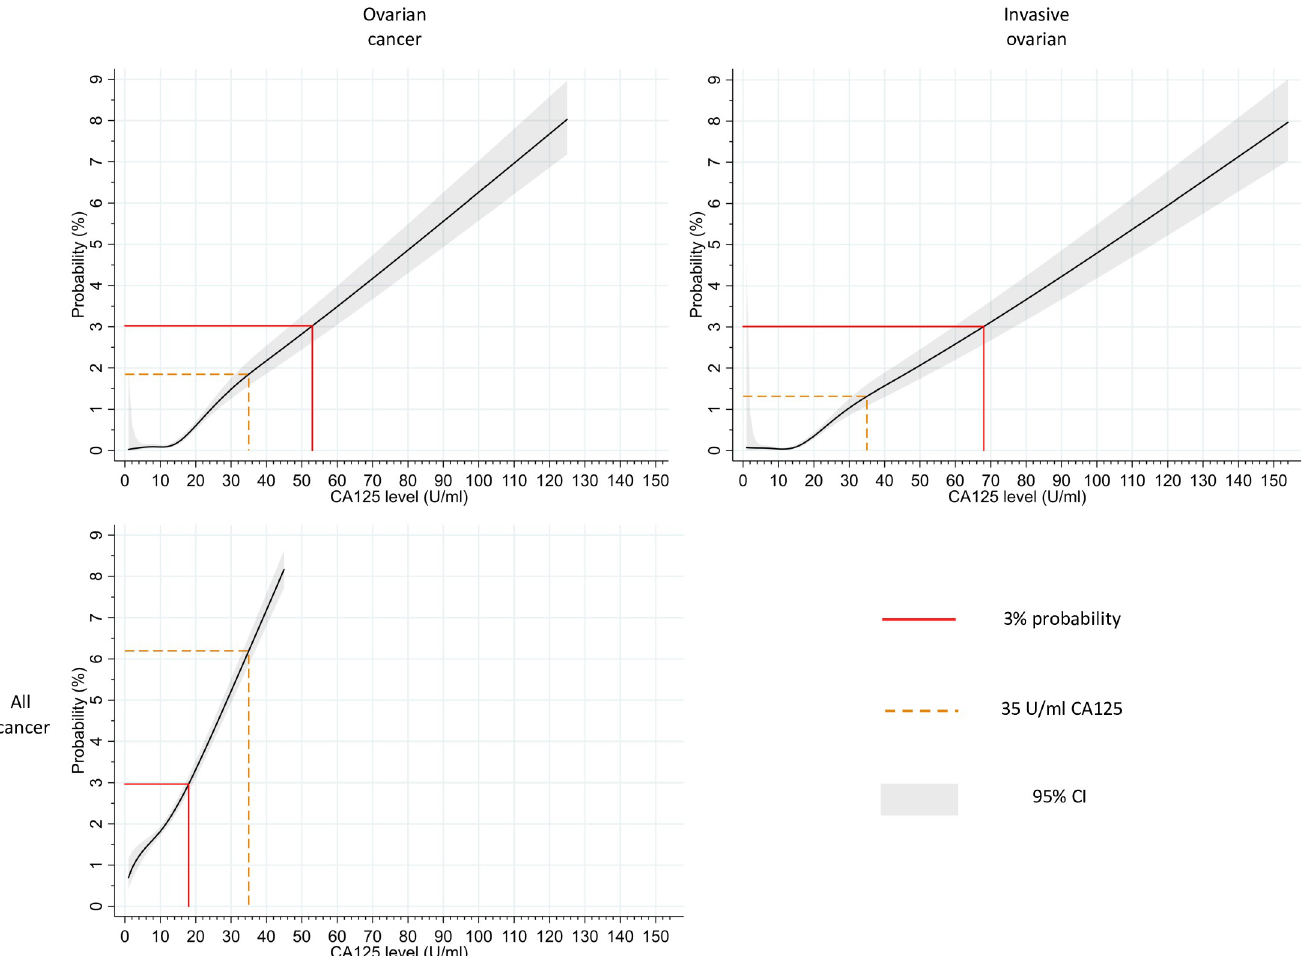
Fig 2. Relationship between CA125 level and estimated probability of ovarian cancer, invasive ovarian cancer, and all cancers. Estimated probabilities up to 8% are shown for ovarian cancer, invasive ovarian cancer, and all cancers. CA125 levels that correspond to the closest integer probabilities of 3% are indicated. The probabilities, which equate to a CA125 level of 35 U/ml, are also marked. Confidence intervals (95%) are displayed. Graphs showing probabilities at an extended range of CA125 values (up to 500 U/ml) for ovarian cancer, invasive ovarian cancer, and all cancer are included in S1 Fig, S2 Fig, and S3 Fig, respectively. Data used to construct these graphs (up to a CA125 level of 1,000 U/ml) are available via the University of Cambridge Repository [27]. CA125, cancer antigen 125; CI, confidence